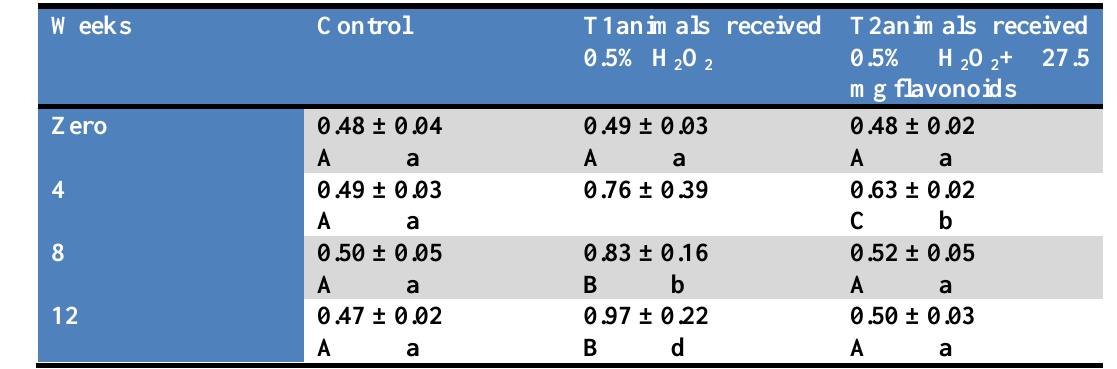
O treated adult male 2 2